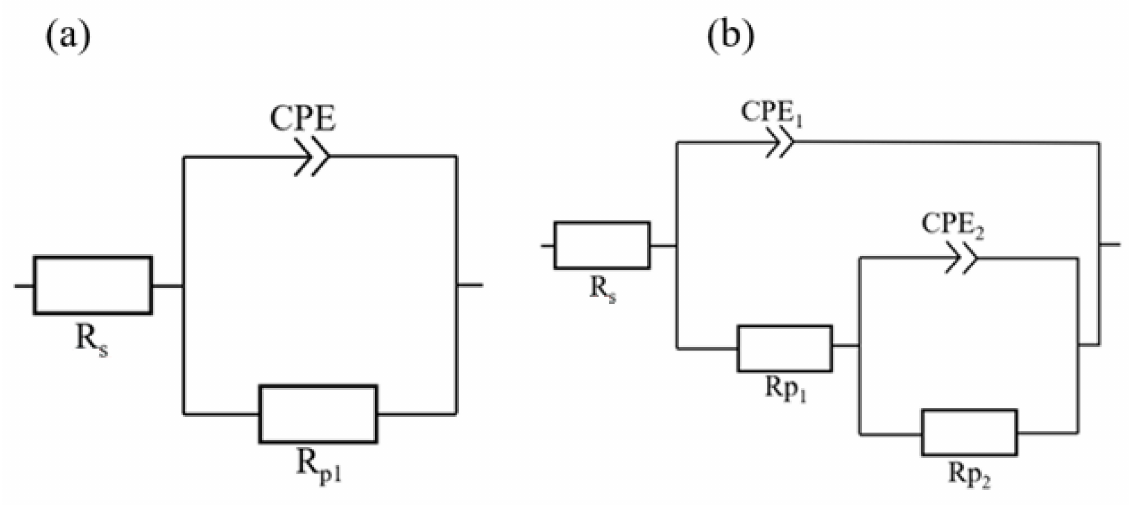
Figure 2. Equivalent circuits for Nyquist plots analysis: ( a ) simple EEC, ( b ) complex